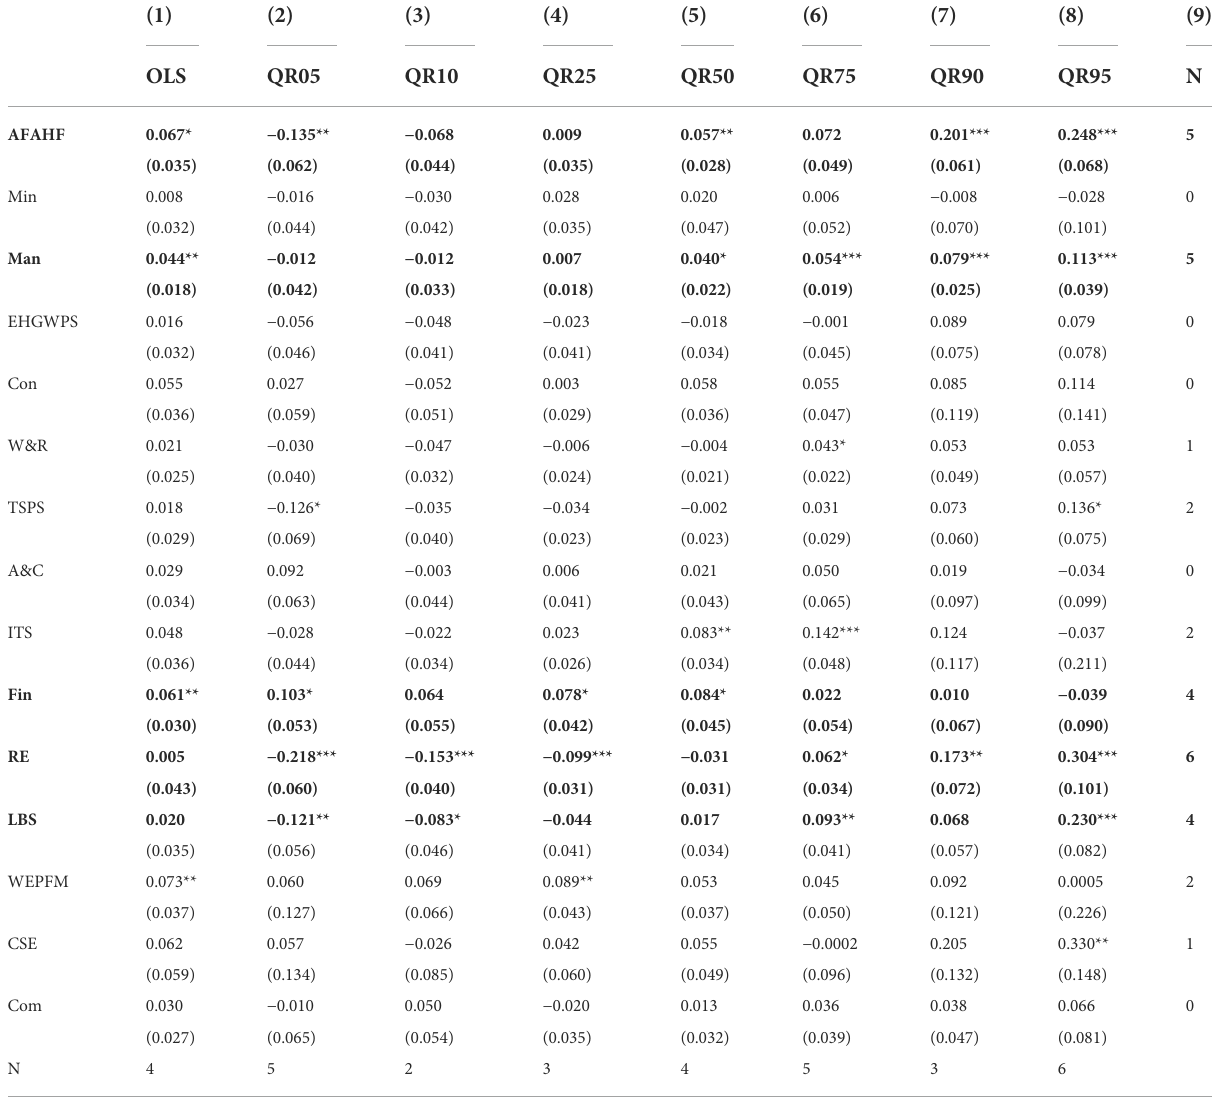
TABLE 11 Robustness check Ⅲ : OLS and quantile regressions based on Trend t − 1